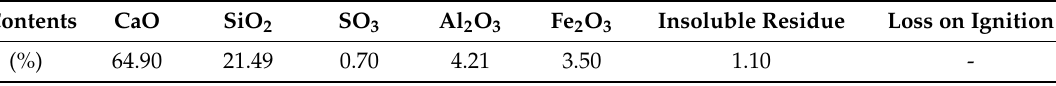
Table 1. Chemical composition of Ordinary Portland Cement